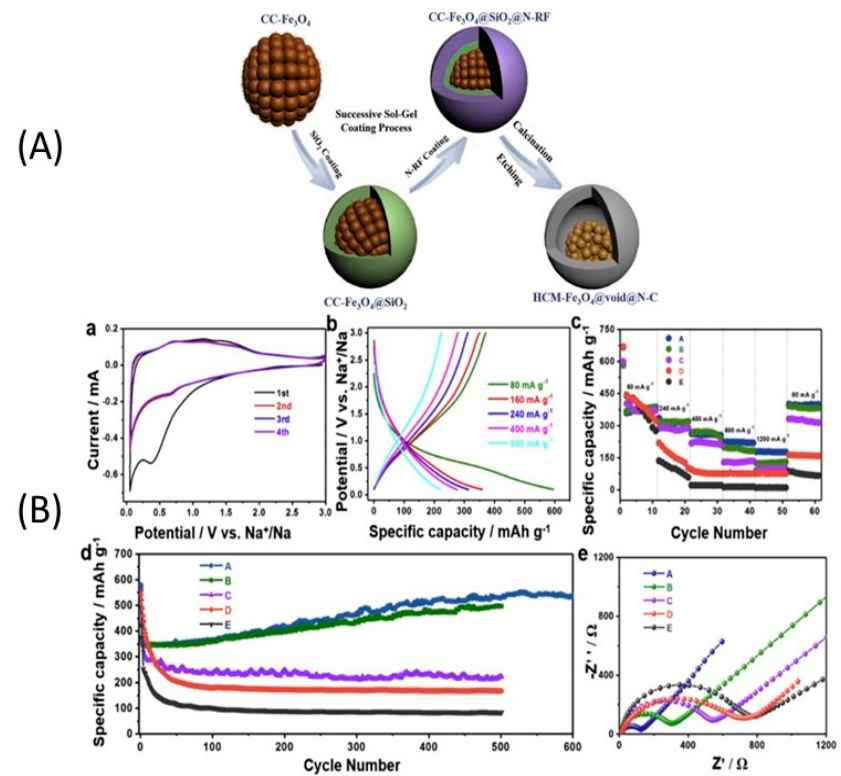
Figure 10. ( A ) Illustration for the synthesis of the yolk-shell structured highly crystallized mesoporous